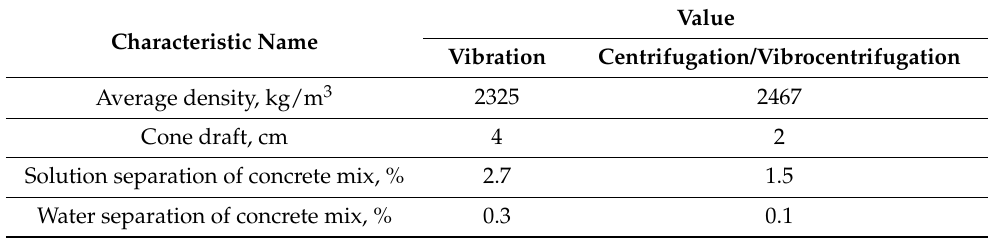
Table 3. Rheological characteristics of concrete mixtures.